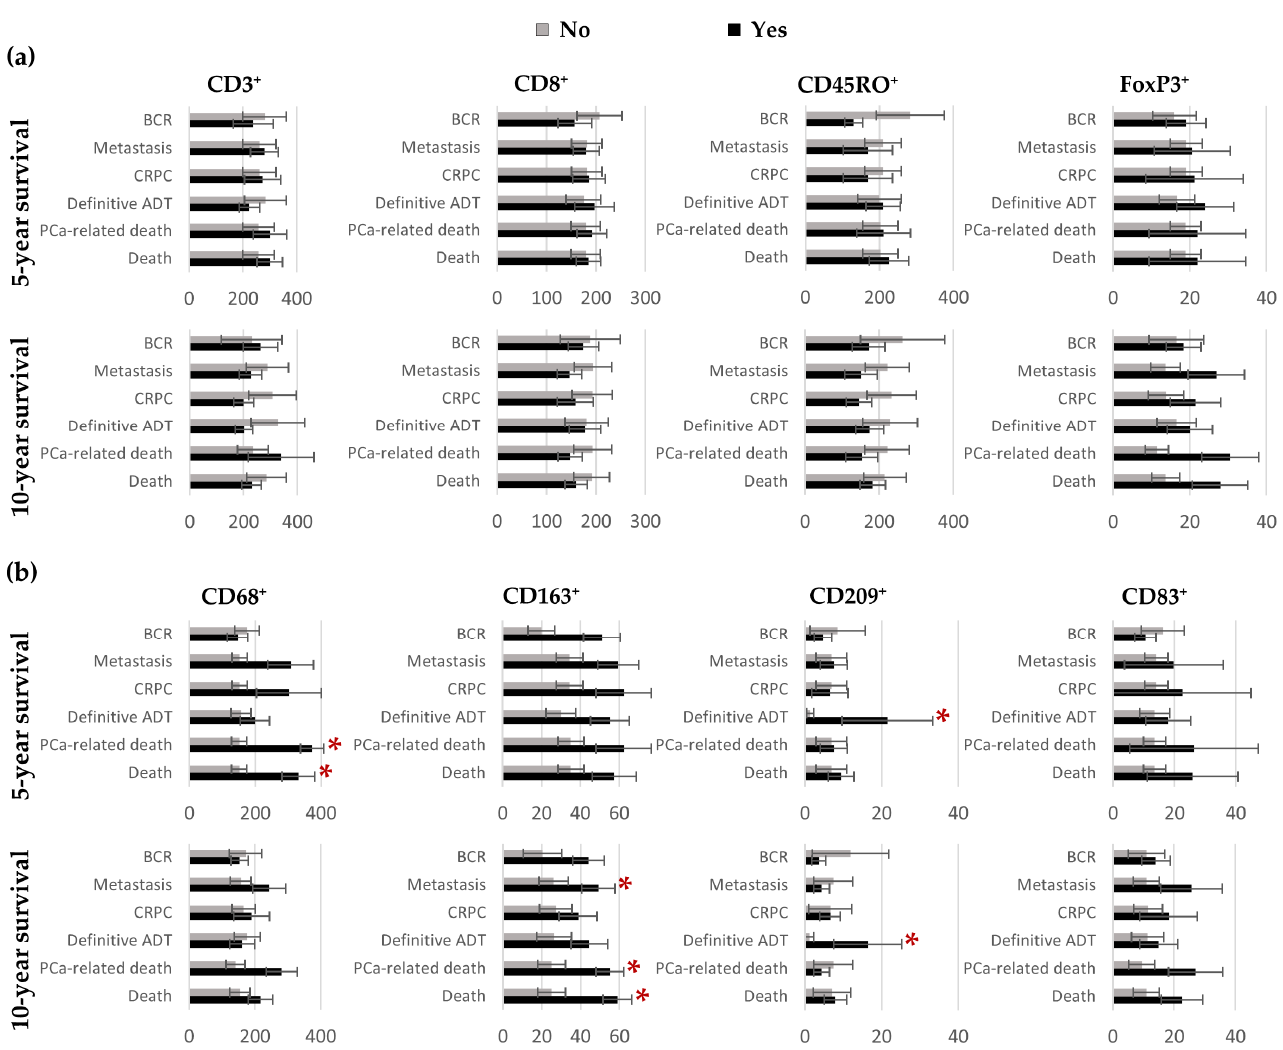
Figure 7. Bar charts representing the mean number of positive T cells ( a ) and antigen-presenting cells ( b ) in IDC-P-immune hotspots according to patients’ outcomes five- and ten-years post-surgery. Error bars represent standard errors. For each cell marker, mean ranks according to survival status were compared using the Mann–Whitney U test and Benjamini–Hochberg corrections were applied to control for multiple comparisons. * Statistically significant p -values. ADT: androgen-deprivation therapy; BCR: biochemical recurrence; CRPC: castration-resistant prostate cancer; IDC-P: intraductal carcinoma of the prostate; PCa: prostate cancer.